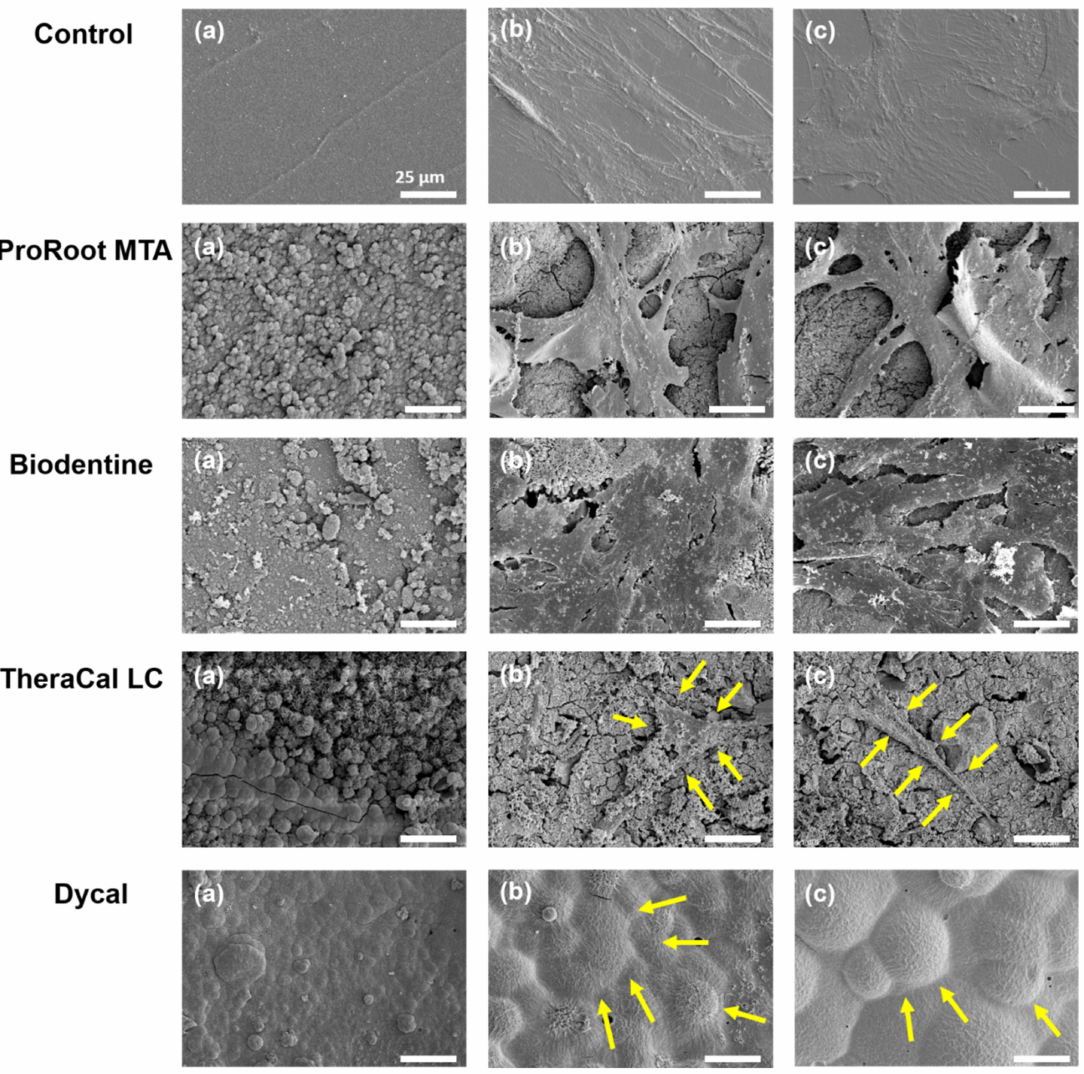
Figure 2. Scanning electron microscopy images show hDPSCs incubated with various pulp-capping materials. hDPSCs were cultured directly on top of solid material disks. ( a ) Material disks before adding hDPSCs ( × 250). ( b ) hDPSCs attached on each experimental disk ( × 250). ( c ) hDPSCs attached on each experimental disk ( × 1000) (scale bar = 25 µ m). Arrows indicate poor cell attachment on TheraCal LC disk and dead cells on Dycal